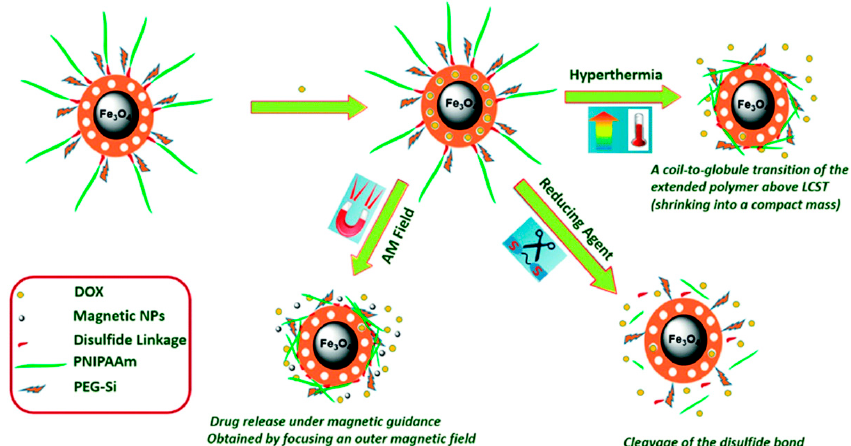
Figure 8. Schematic representation of a triple responsive release mechanism of drug from PNIPAAm coated magnetic MSNs. Reproduced with permission from reference [35].